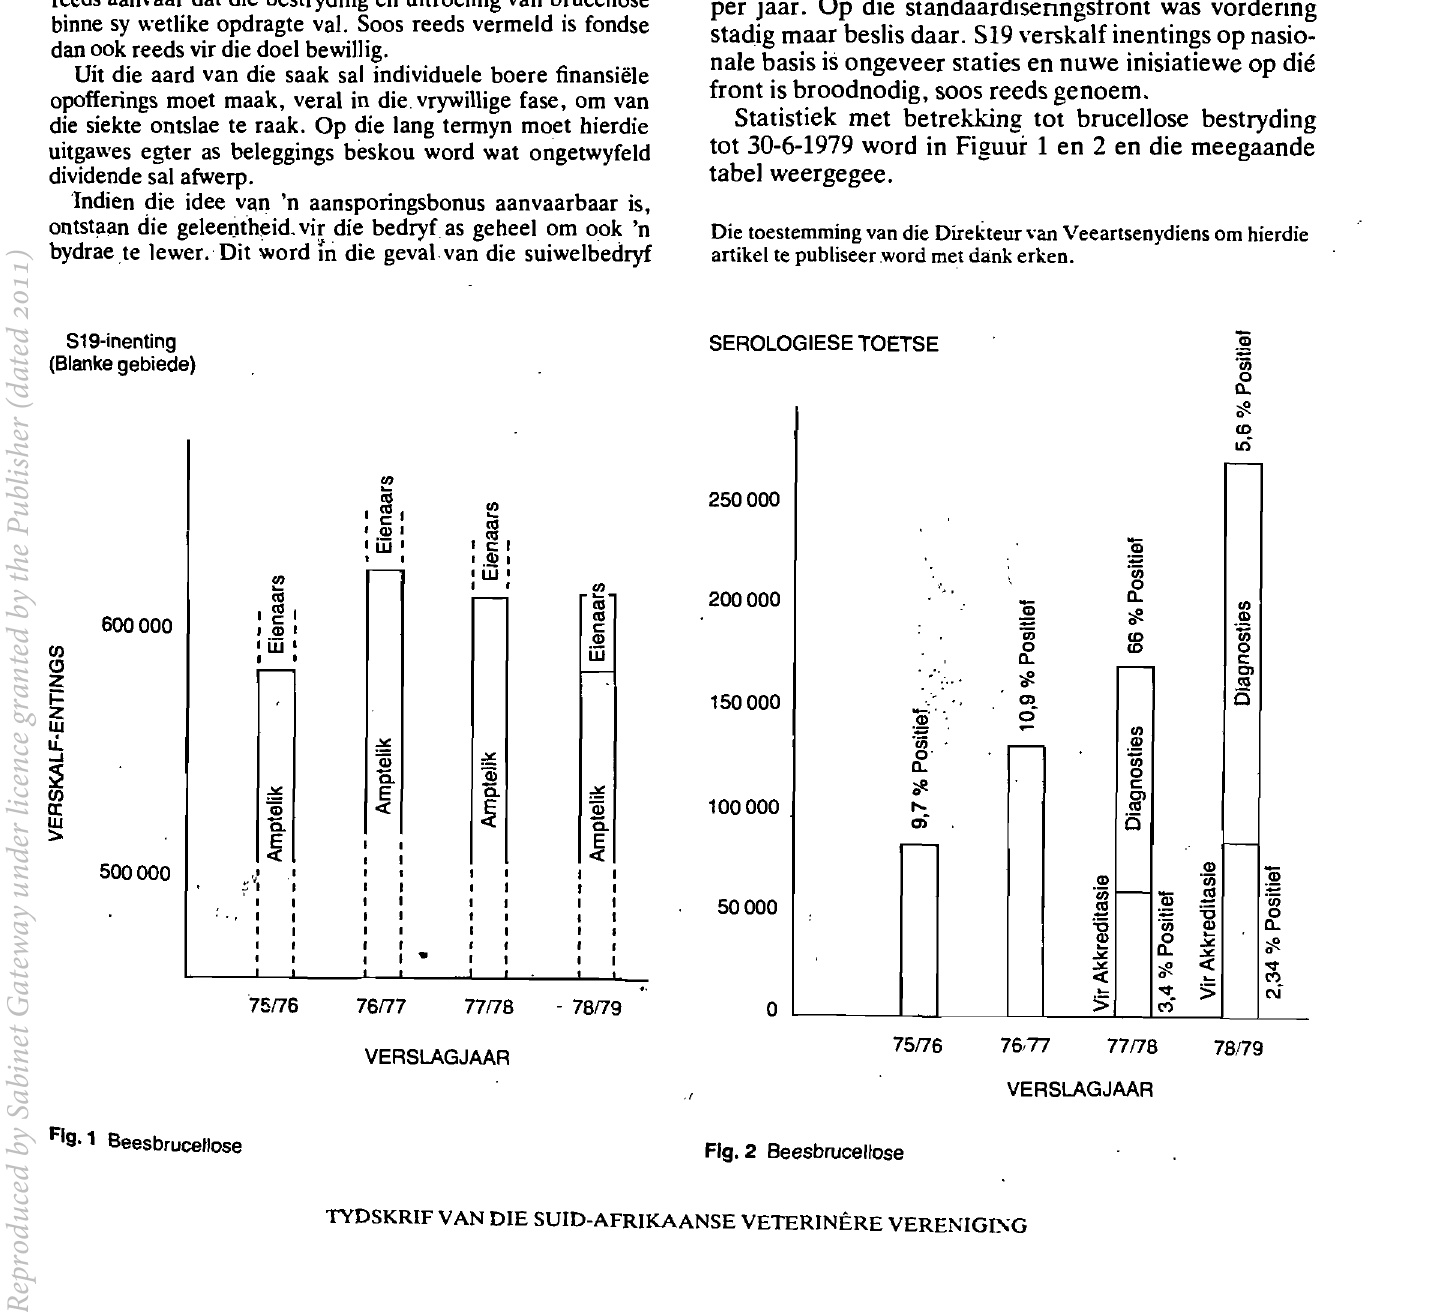
TYDSKRIF VAN DIE SUID-AFRIKAANSE VETERINERE